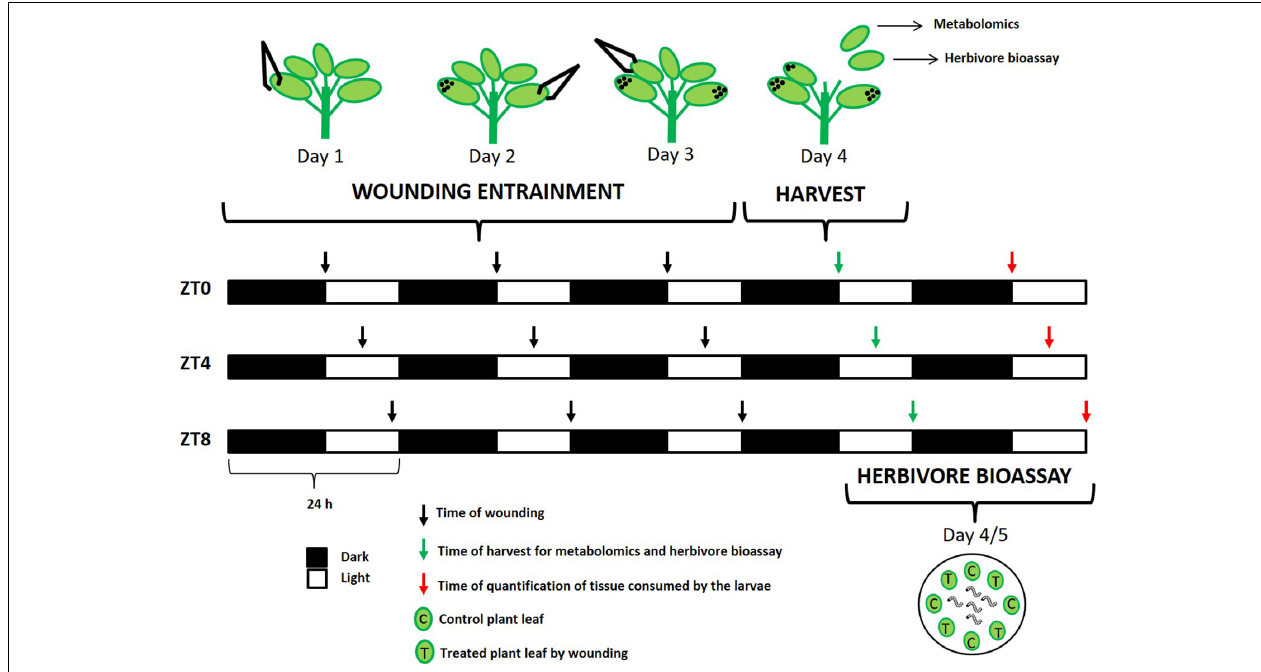
FIGURE 1 | Scheme of the wounding treatment at different time points (ZT0, dawn; ZT0, mid-day; ZT8, dusk). Plants were wounded during three consecutive days and harvested at fourth day. Black arrows represent the time of day at which wounding was performed. Green arrows represent the time of day at which leaves were harvested for metabolomics and herbivore bioassay. Red arrow represents the time of day at which quantification of tissue consumed by the larvae was done for each experiment. Black dots on the leaves indicate previously wounding